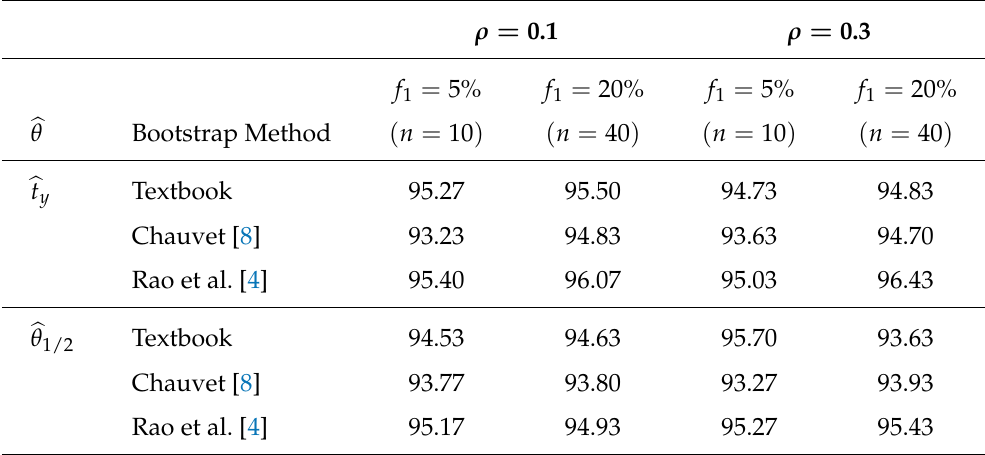
Table 8. Coverage rate (CR) of the 95% t -distribution based confidence intervals constructed using bootstrap standard error estimators based on 3000 samples selected according to